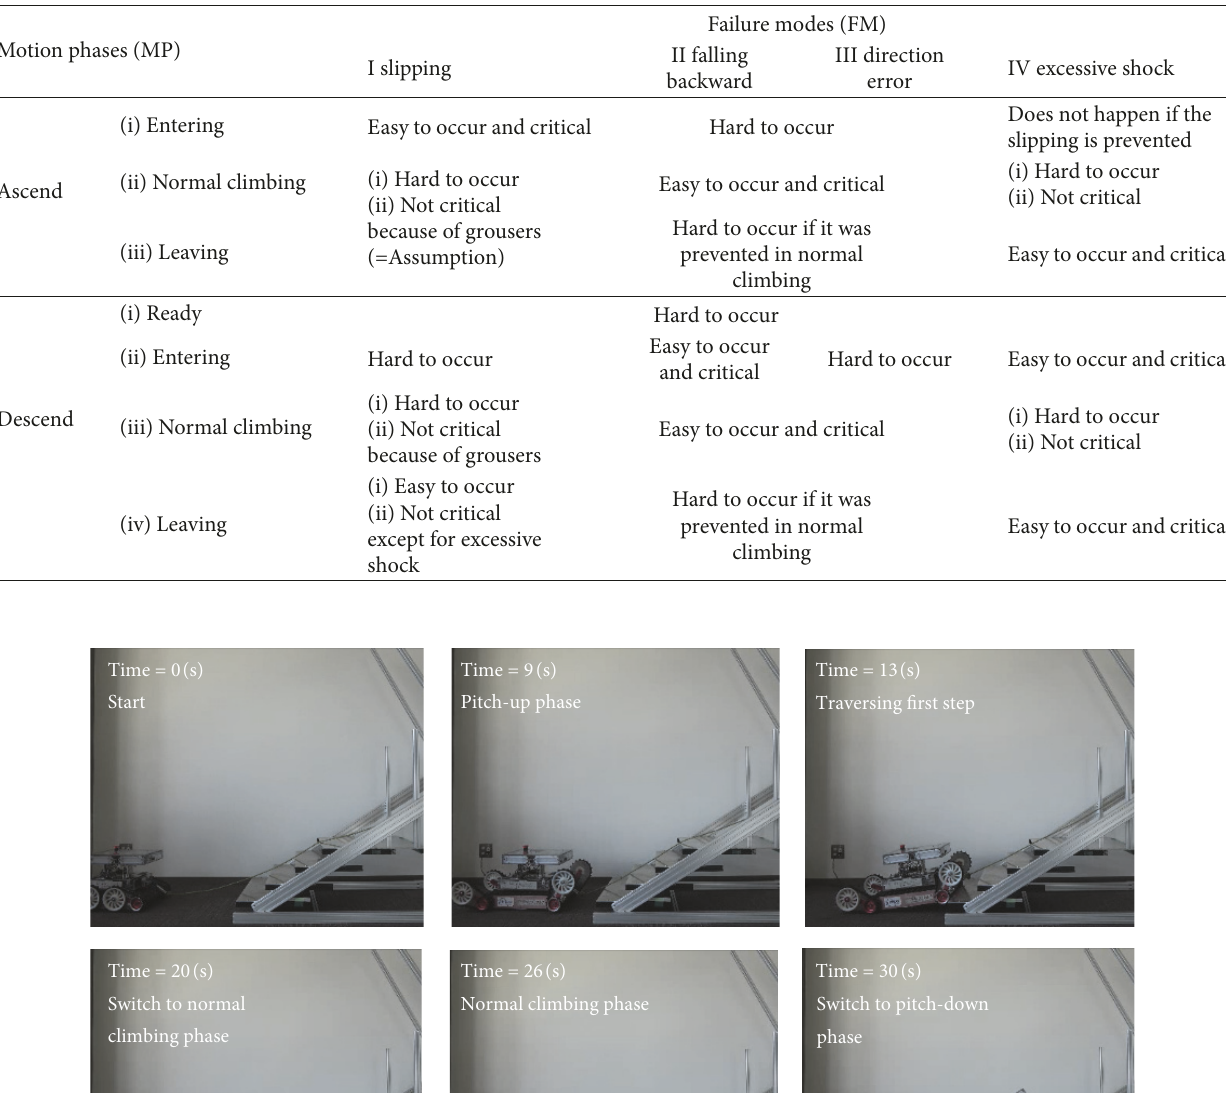
Table 2: Relationship between motion phases and failure modes.